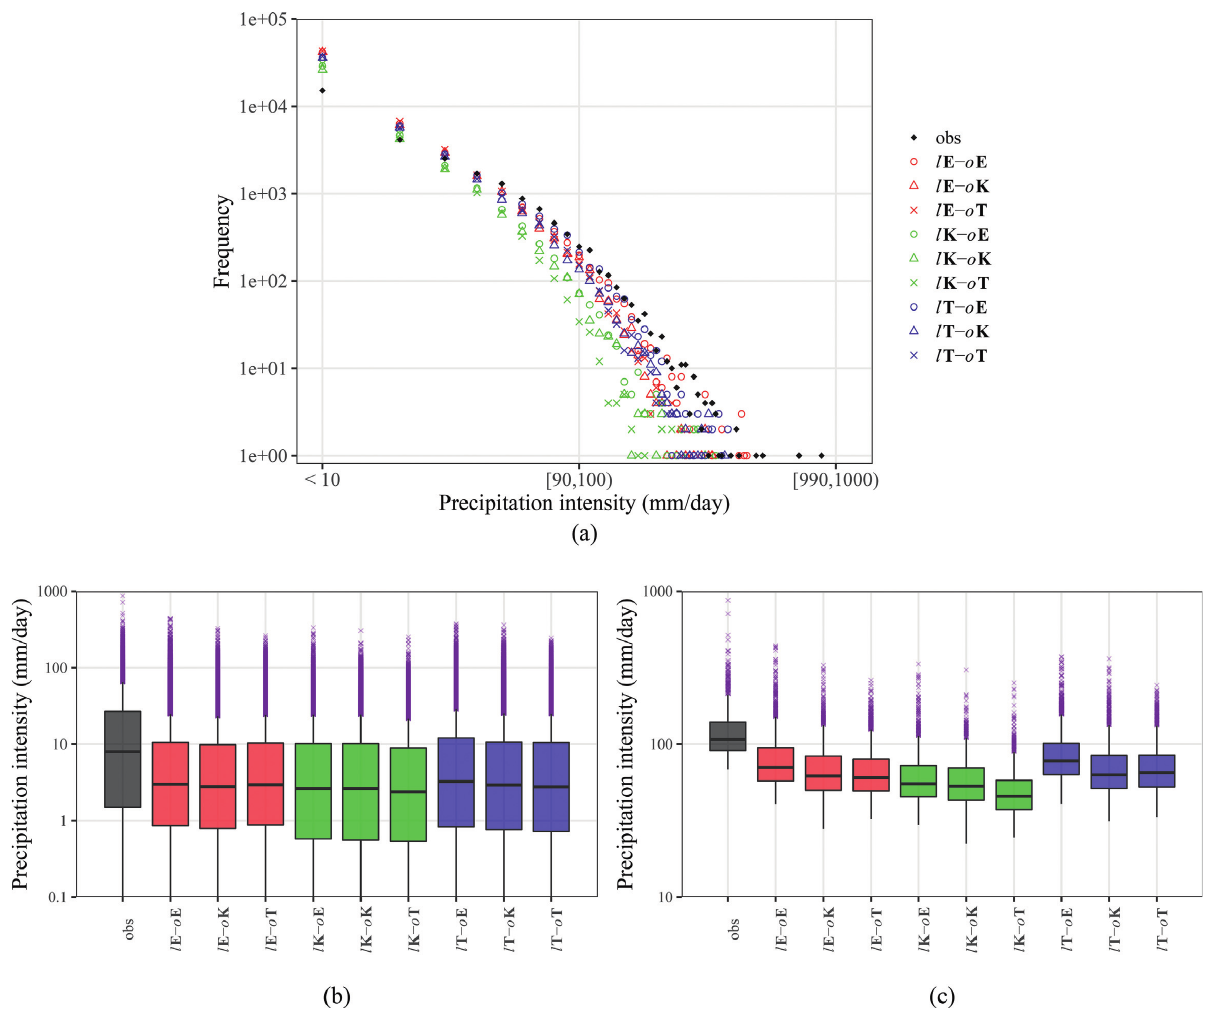
Figure 7: (a) Frequency distribution of daily precipitation and boxplot of (b) daily precipitation and (c) extreme daily precipitation exceeding the 95th percentile, derived from the in situ observation and model simulations interpolated to the station sites. The thick black line within each box represents the median value. The square bracket in (a) represents the precipitation intensity greater than or equal to the value, while the parenthesis represents the precipitation intensity less than the